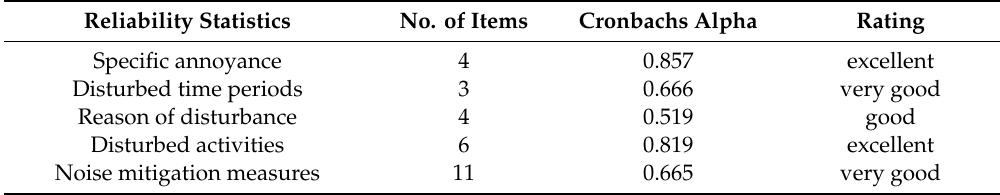
Table 2. Reliability test results on item